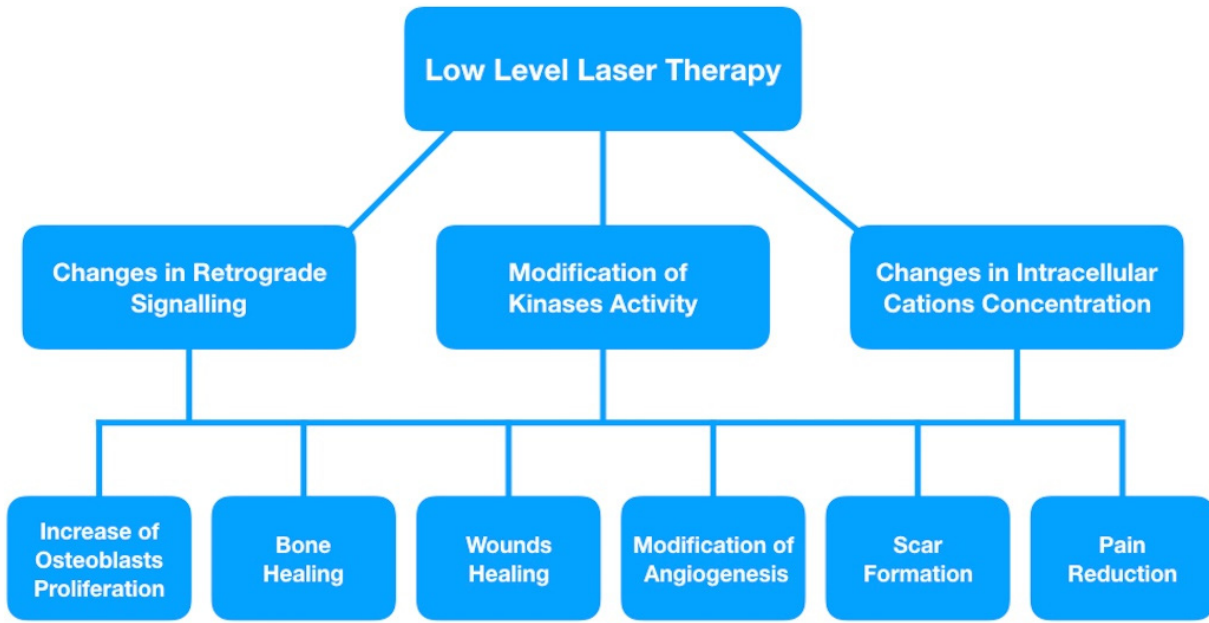
Figure 3. Changes in cell signaling process and its clinical application.